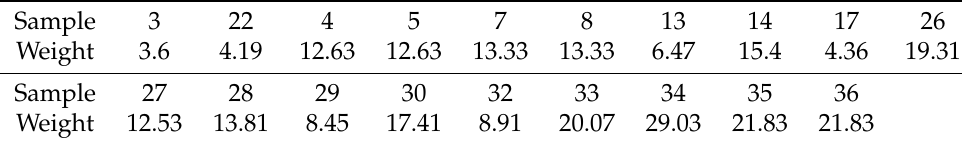
Table 1. Weight in grams of the